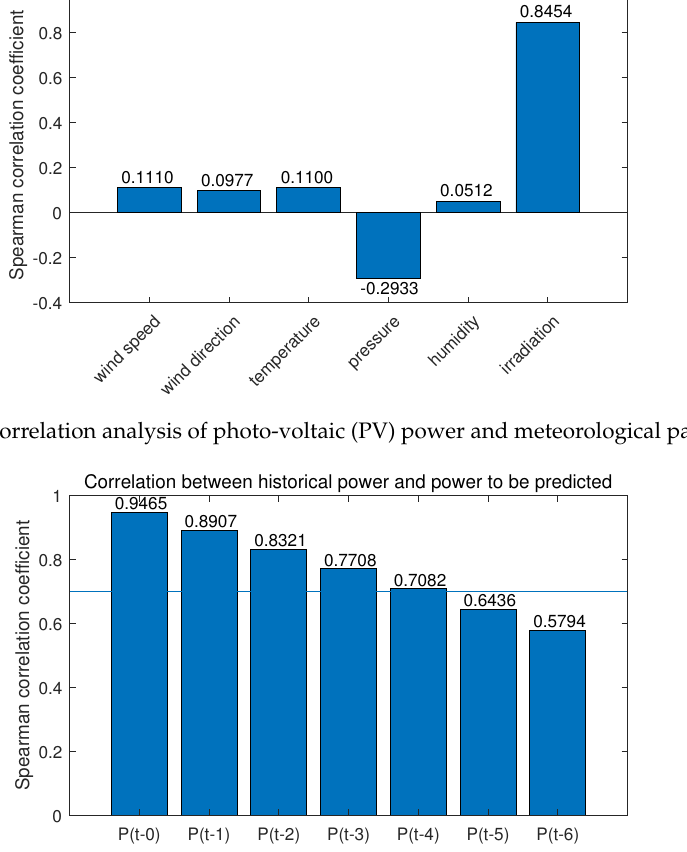
Figure 4. Autocorrelation analysis of PV